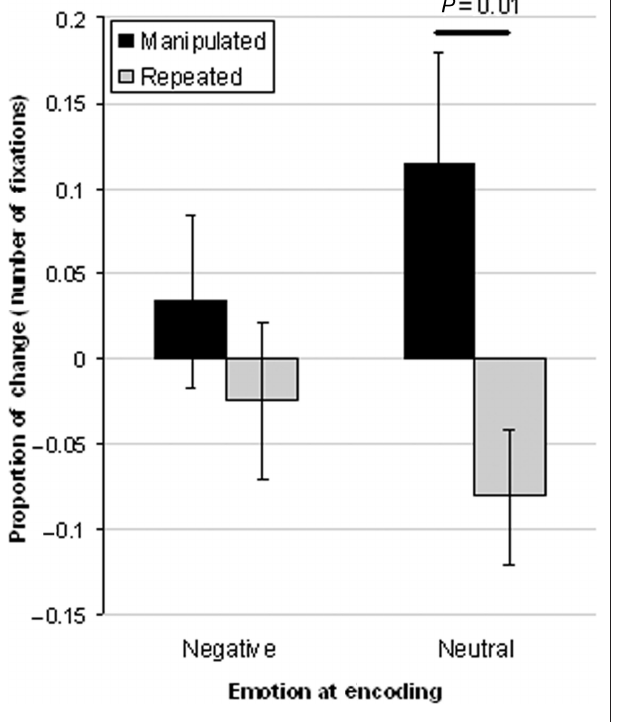
Figure 2 | The proportion of change in viewing the critical object in a manipulated and repeated object array relative to a novel object array. Participants directed more fixations to the critical object in manipulated versus repeated object arrays for objects previously encoded in a neutral, but not in a negative